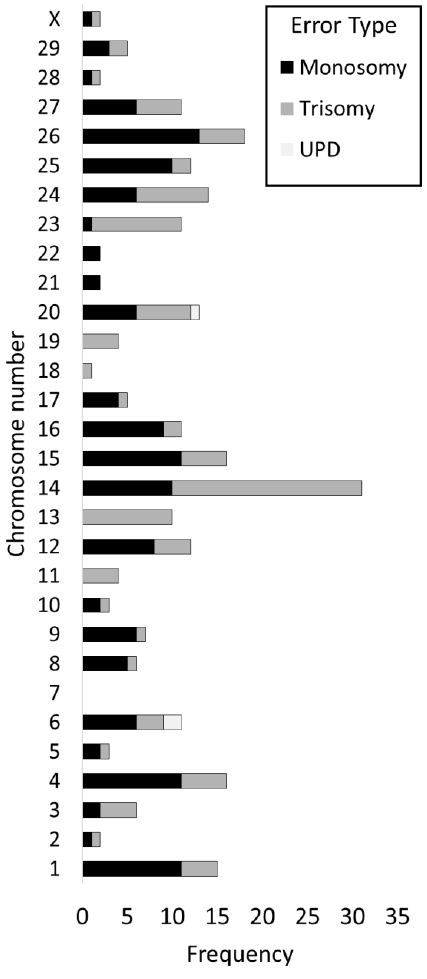
Figure 5. Whole chromosome error incidence by chromosome. Individual chromosomes were affected by aneuploidy at different rates, with specific chromosomes displaying a higher or lower incidence than expected. For example, monosomy and trisomy affected chromosome 14 at a much higher rate, whilst errors involving chromosome 7 were not detected in this database. N = 255 whole chromosome